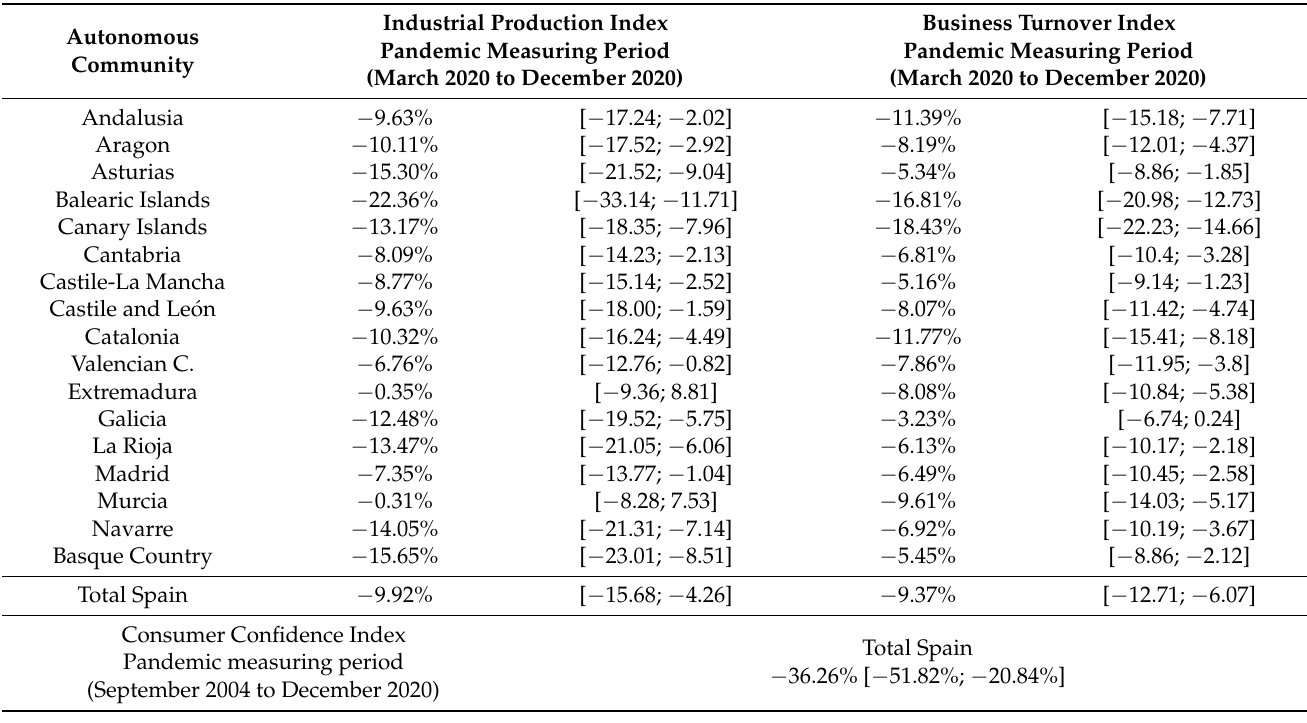
Table 2. Bayesian structural time series model results for production, supply, and demand: relative cumulative effect (95% Bayesian credible interval).